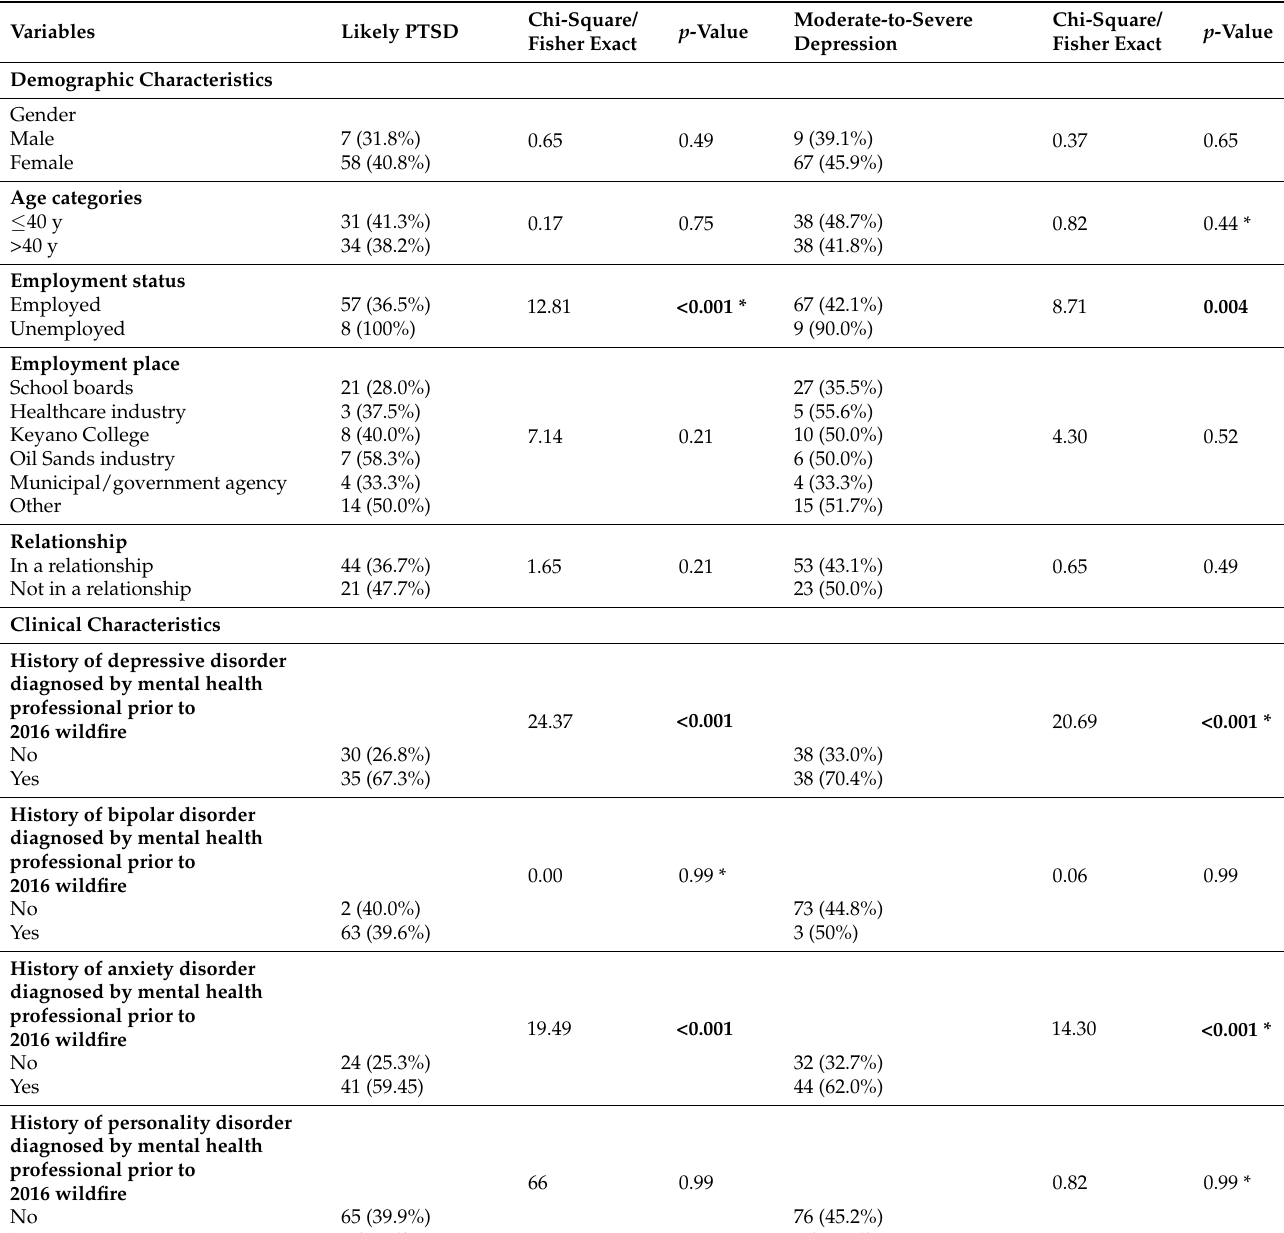
Table 2. Chi-squared/Fisher exact test of association between the demographic, clinical, and wildfire- related variables and MDD and